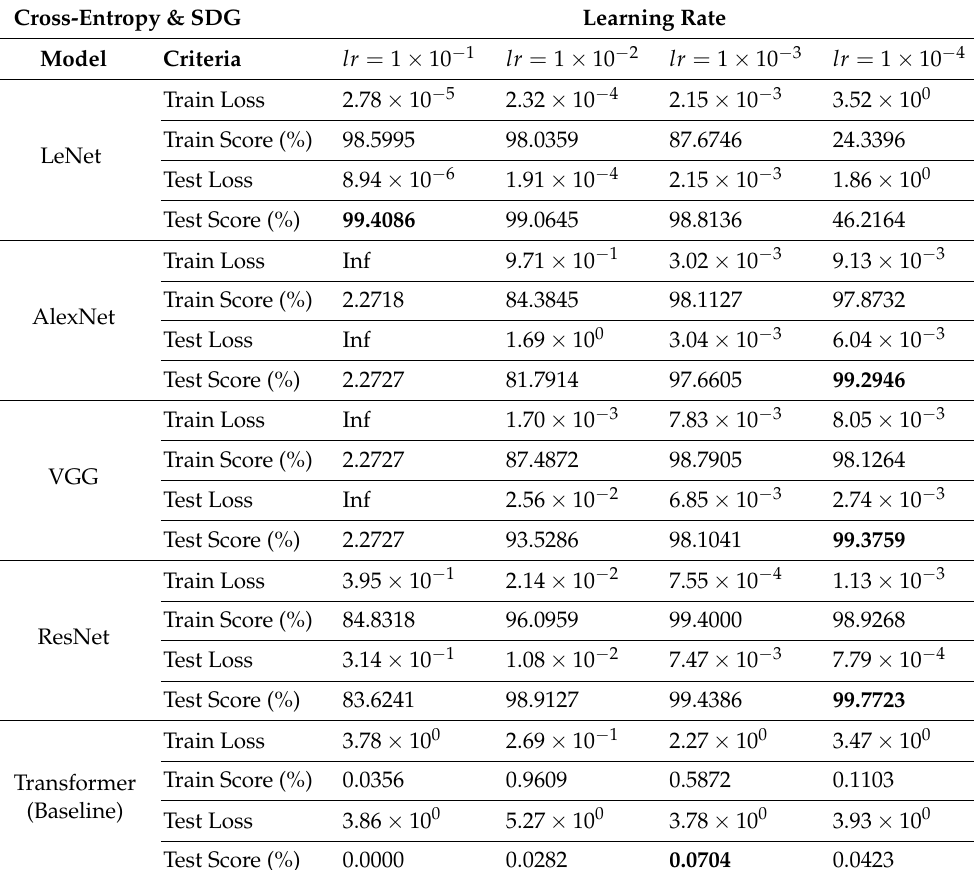
Table 4. All of the models use cross-entropy for the loss and stochastic gradient descent (SDG) for the optimizer. The bold value for the test score represents the best learning rate for performance. All of the loss values are in scientific notation while the scores are in percentage values, where “Inf” represent a very large loss